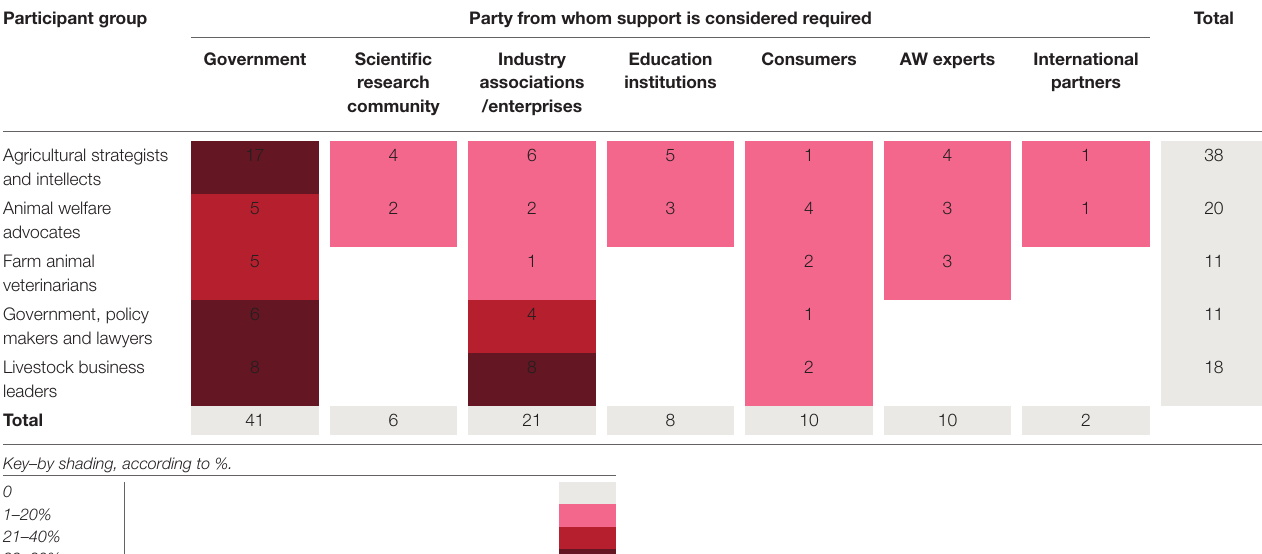
TABLE 7 | Participant response to ‘who’ is needed to provide support to the agricultural sector in order to improve animal welfare in China by participant group. Participant group Party from whom support is considered